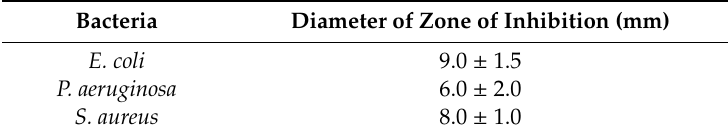
Table 6. Antimicrobial activity of functional biocomposite